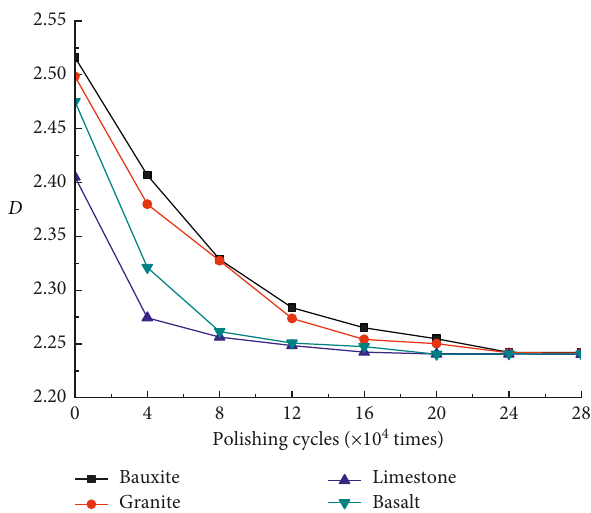
Figure 4: Variation of D during the long-term polishing process.